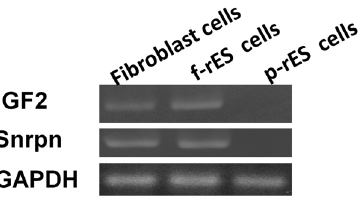
Figure 9. The imprinted gene expressions in fibroblast, f-rES, and p-rES cells. Rabbit fibroblasts and f-rES cell line (R4) all expressed Igf2 and Snrpn , but not the p-rES cells line (A2).